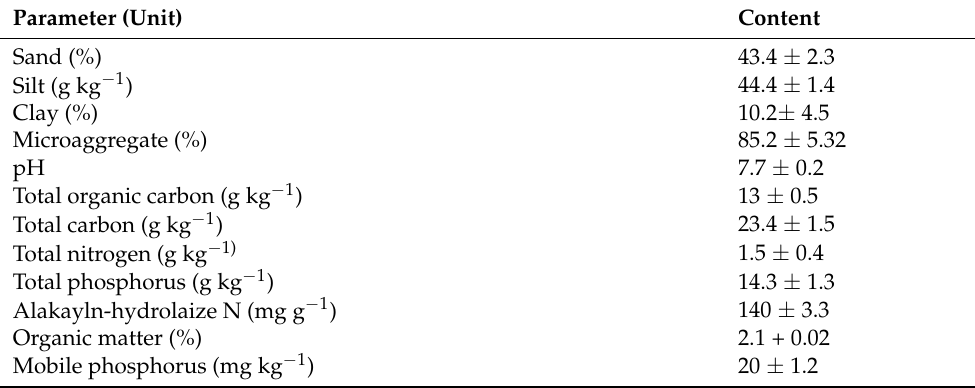
Table 1. Basic characteristic of the soil prior to sowing